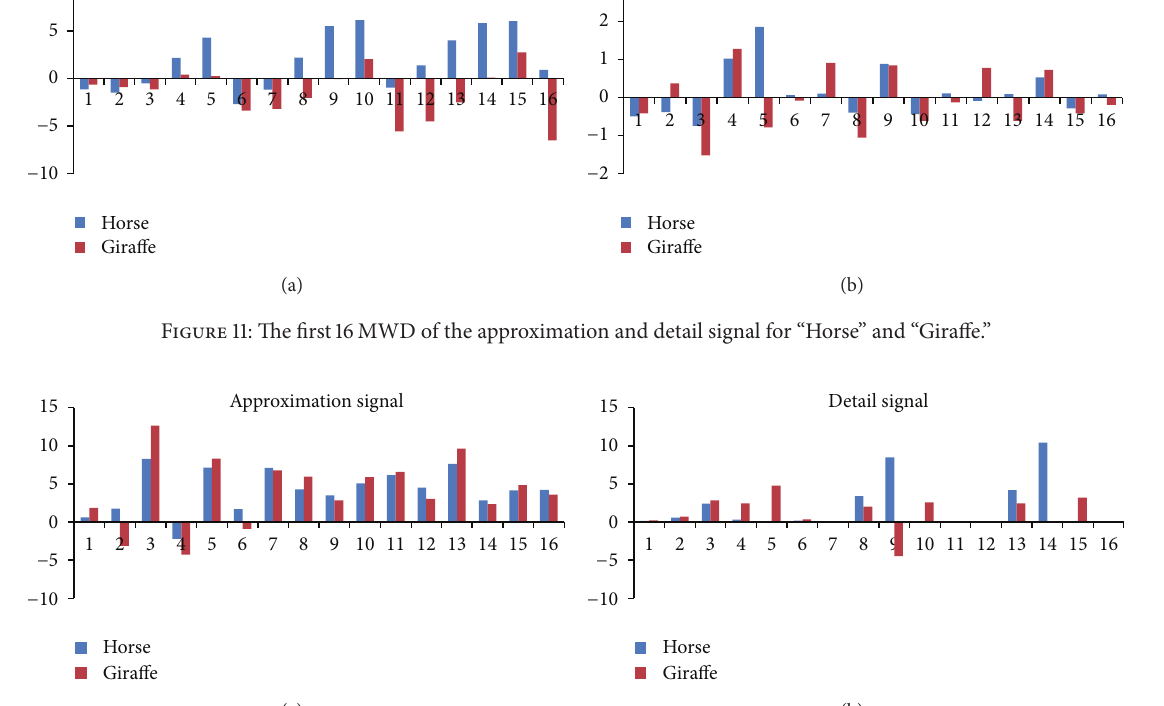
in green color. The dilatation or compress parameter 𝑎 and shifting parameter 𝑏 are calculated as given in (23) for 𝑟 ∈ {1, 2, 3, 4} and 𝑘 ∈ {0, 1, 2, 3} . The reported experimental results are calculated in all cases using the described strategy in Section 10 to ensure starting point